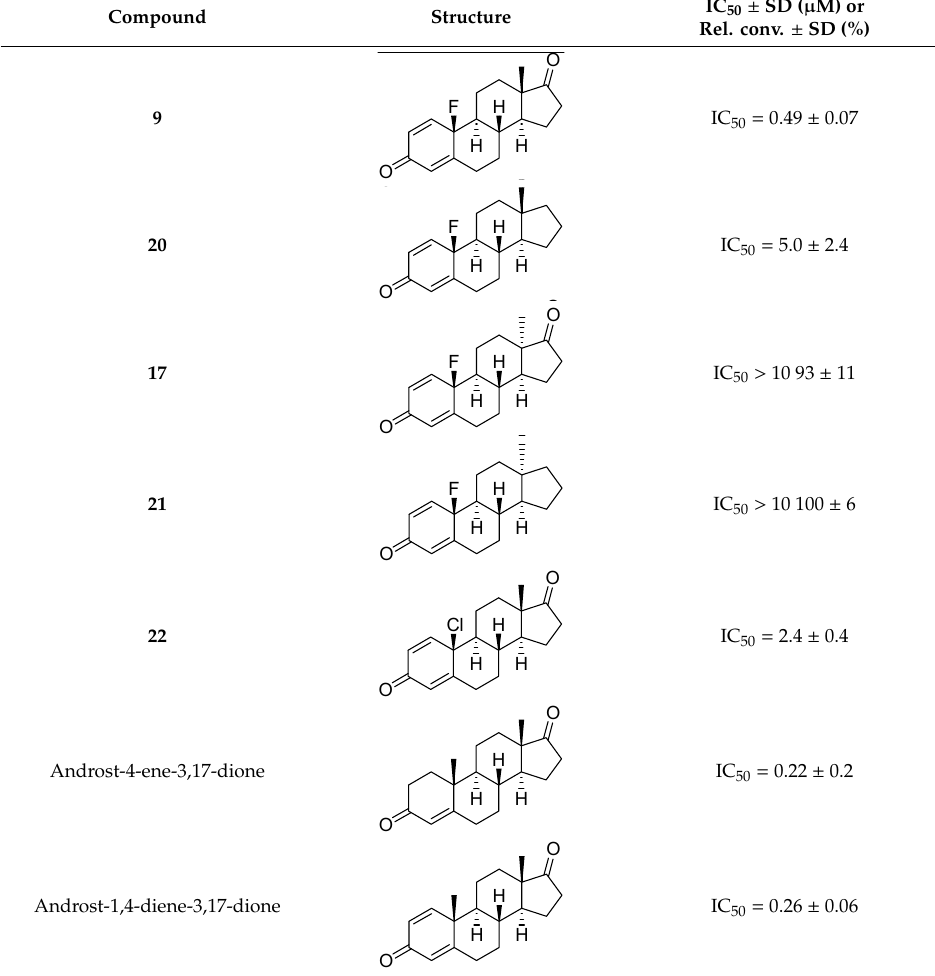
Table 3. In vitro inhibition of aromatase activities by the test compounds and reference agents. Relative conversions (Rel. conv., control incubation with no inhibition is 100%) measured in the presence of 10 µM concentration of the compound tested. Mean ± SD, n = 3. IC 50 : inhibitor concentration decreasing the enzyme activity to 50%. SD: standard deviation.